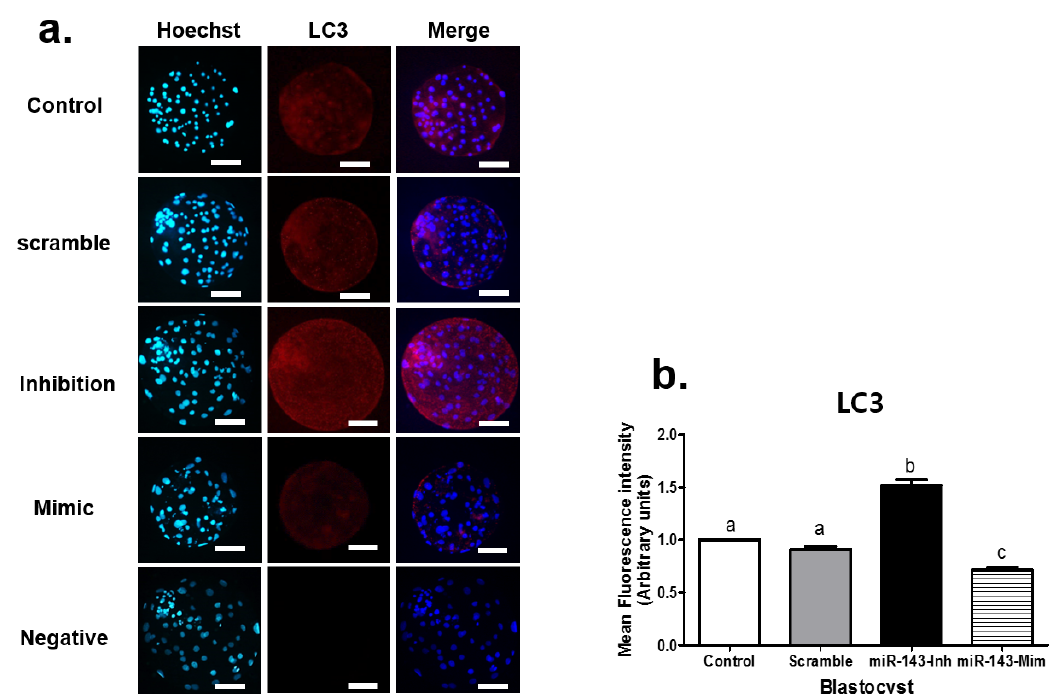
Figure 2. LC3 immunostaining in blastocyst stage embryos on Day 7 after microinjection with miR- 143. ( a ) Representative fluorescence images of LC3 expression and Hoechst staining. In addition, merge is the combination figure of Hoechst and LC3 staining. ( b ) Graph showing quantitation of LC3 fluorescence intensity. Data are presented as standard error of the mean (±SEM), with each experiment performed using at least 24 embryos per group, obtained from four biological replicates. Groups labeled with different lowercase letters indicate statistically significant differences ( p < 0.05). Scale bars = 50 µ m, magnification = 400 × . miR-143-Inh = microRNA 143-Inhibitor, miR-143-Mim